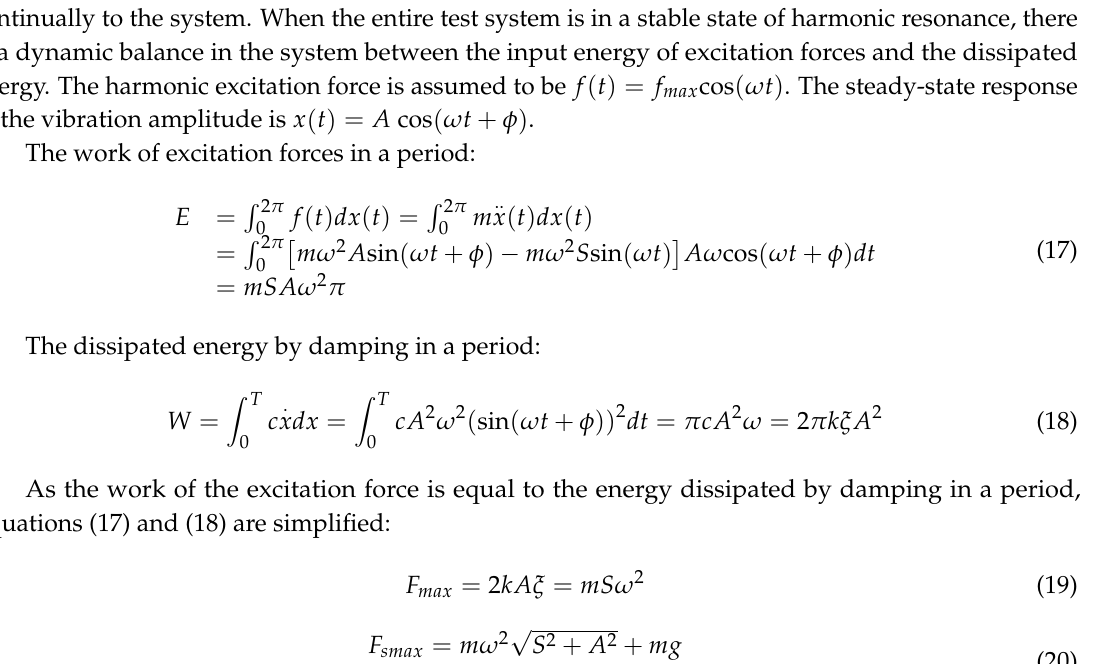
Figure 15. Comparison of the spatial damage distribution against the target distribution for single-point excitation and multi-point excitation.